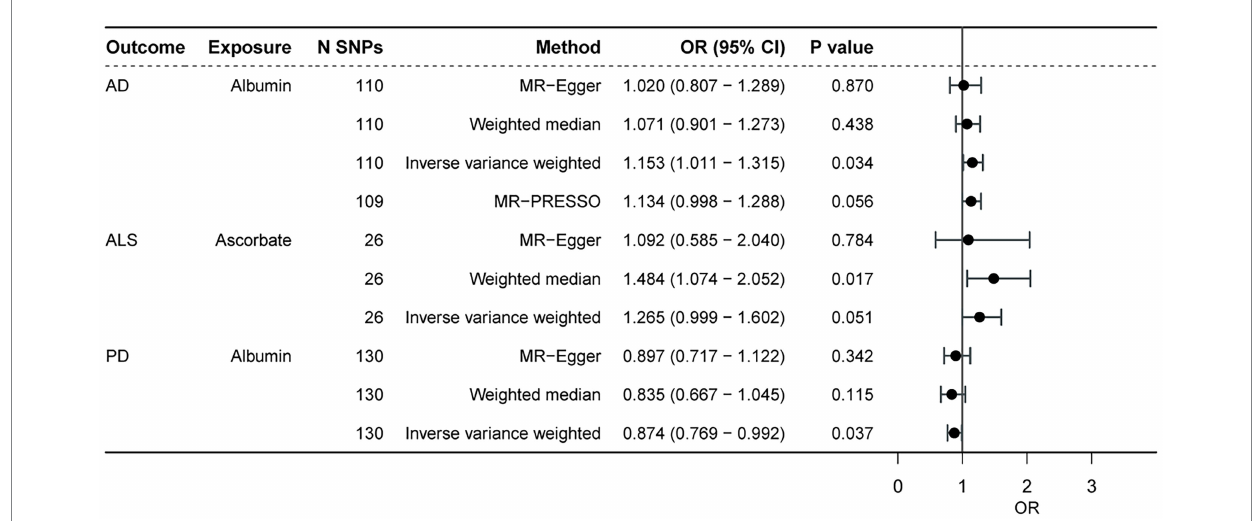
FIGURE 2 The causal effect of antioxidant biomarkers on the neurodegenerative diseases. AD, Alzheimer’ s disease; ALS, amyotrophic lateral sclerosis; PD, Parkinson’ s disease; SNP, single nucleotide polymorphism.